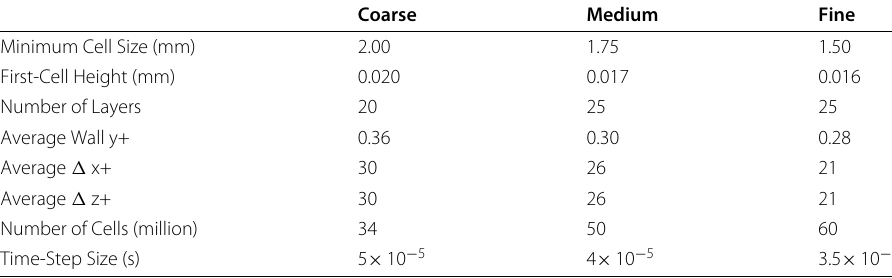
Table 1 Mesh and time-step details